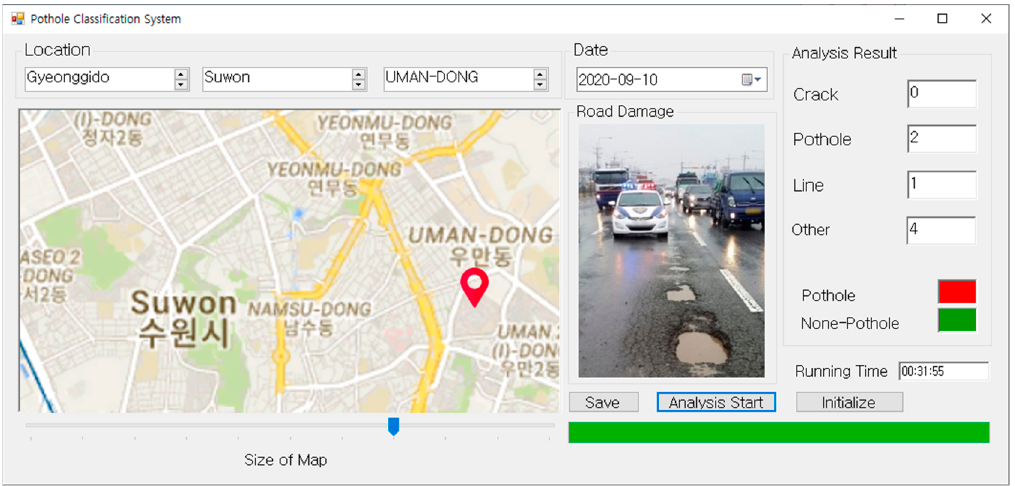
Figure 7. The road traffic pothole classification system.